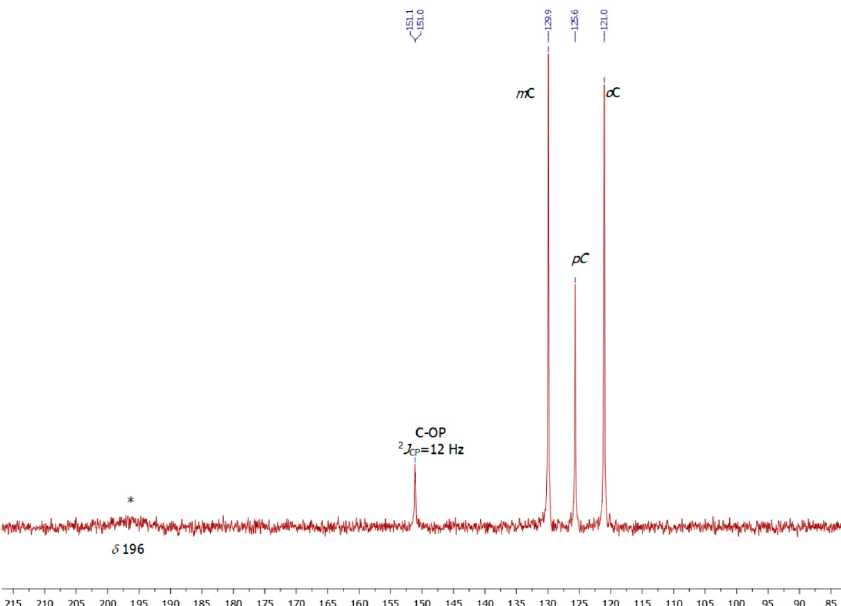
Figure 2. 31 P{ 1 H} NMR spectrum (161.99 MHz, CDCl 3 ) of compound 2 at 25 °C .